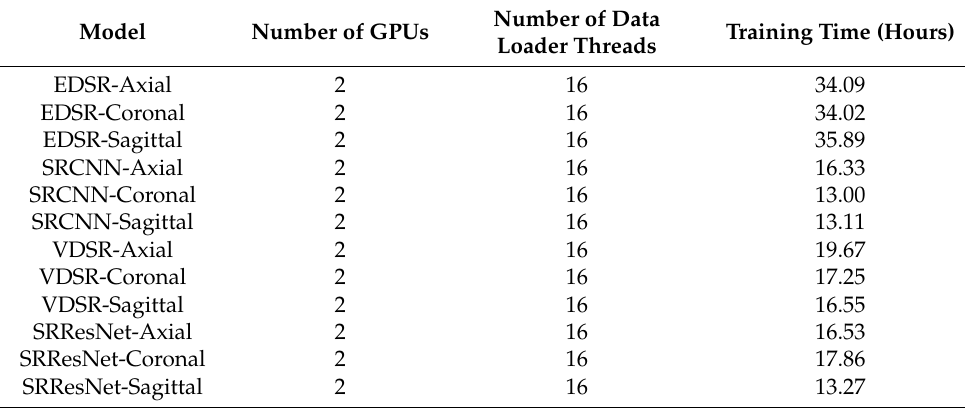
Table 3. Training time.